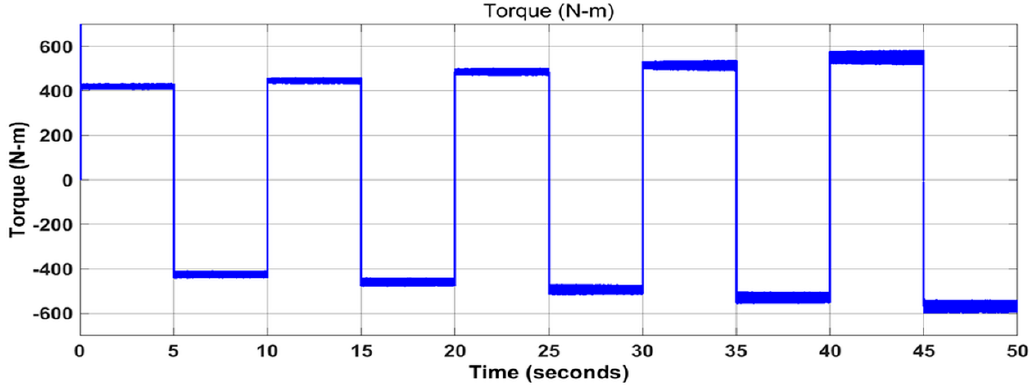
Figure 7. View of the motor’s back electromotive force waveform.